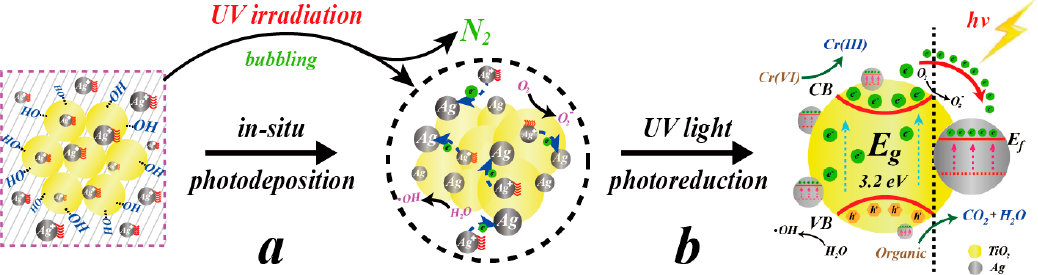
Figure 1. Schematic illustration of ( a ) synthesis of ultra-trace silver doped TiO 2 composites via ultrasonic impregnation assisted deposition through an in situ UV-assisted photoreduction strategy; ( b ) photoreduction of highly toxic Cr(VI) to nontoxic Cr(III) by resultant Ag@TiO 2 photocatalysts under UV irradiation.